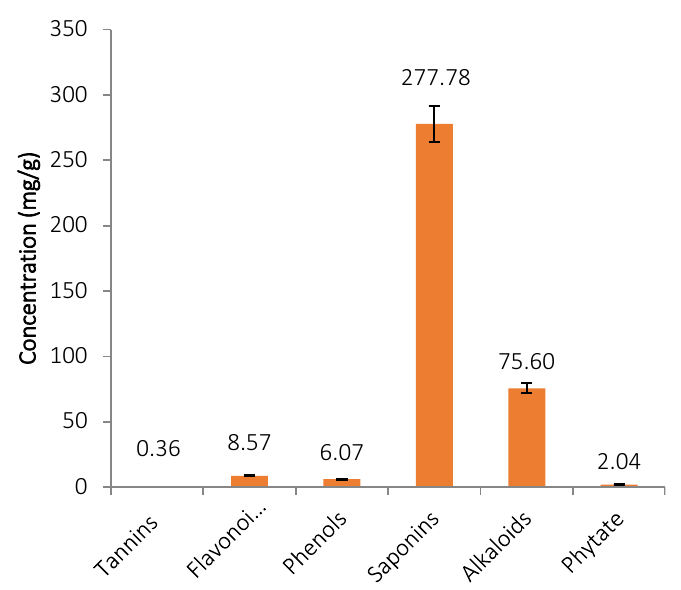
Figure 2. Phytochemical composition of A. occidentale